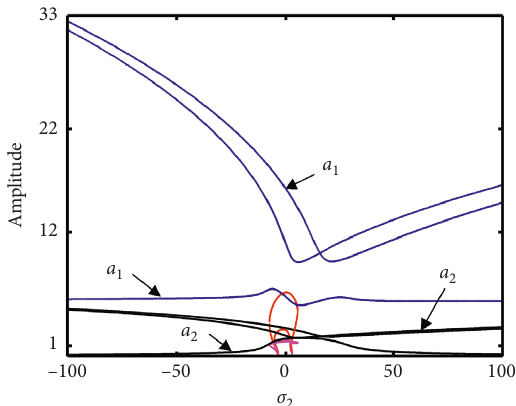
Figure 8: Frequency-response curves obtained when g j � 0 . 08, and σ 1